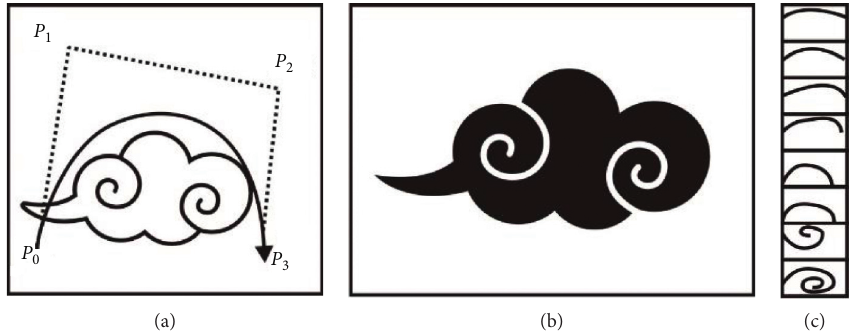
Figure 3: Feature extraction. (a) Cubic bexier curve, (b) sample fitting, (c) feature